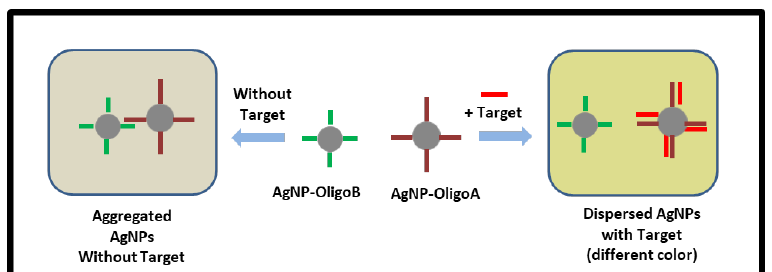
Figure 3. Schematic diagram showing the operating principle of the colorimetric sensing method using nanoparticle-base assay. Left: Aggregated AgNPs without target. Right: Disperesed AgNPs with target.